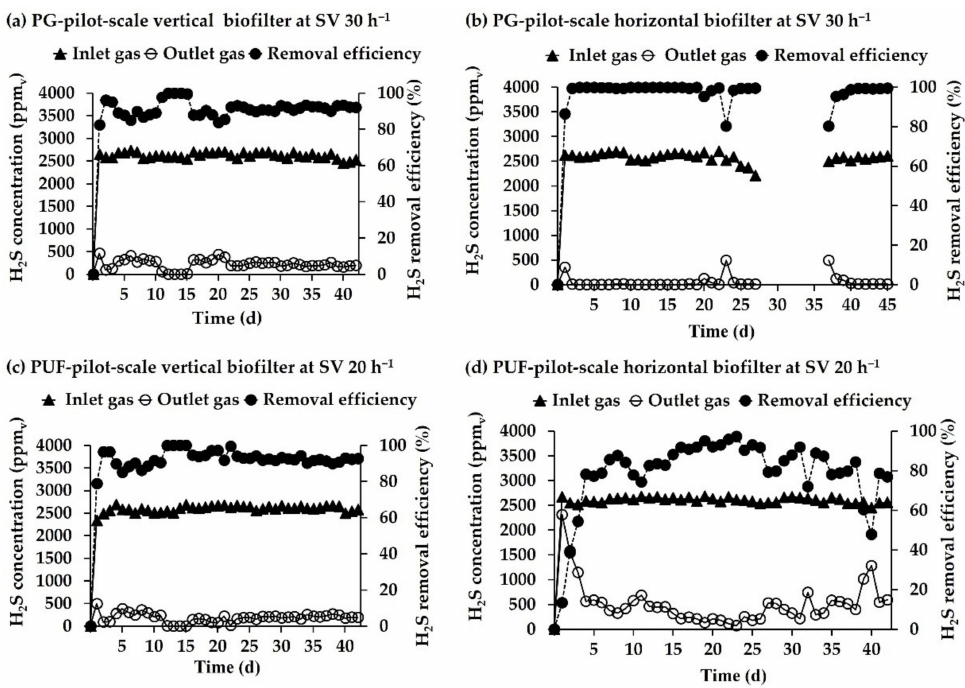
Figure 5. Inlet/outlet H 2 S and H 2 S removal efficiency in the pilot-scale biofilters packed with immobilized P. versutus CM1 cells on PG with SV of 30 h − 1 , ( a ) vertical and ( b ) horizontal positions and PUF with SV of 20 h − 1 , ( c ) vertical and ( d ) horizontal